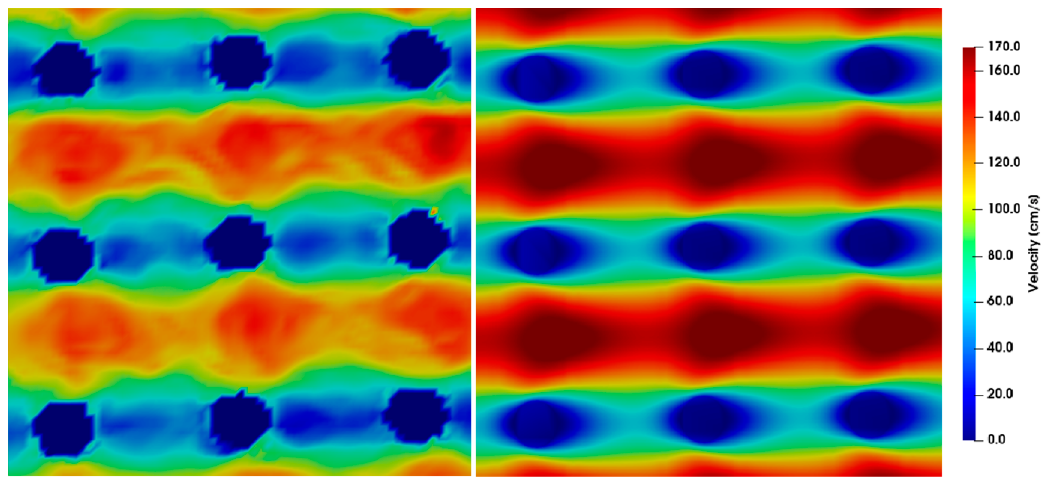
Figure 10. µPIV measurements ( left ) compared to simulations ( right ) showing the velocity field around posts at Re = 11.43. The direction of flow is from left to right, the pitch between the posts is 20 µm and the time difference between double frames is dt = 1 µs.